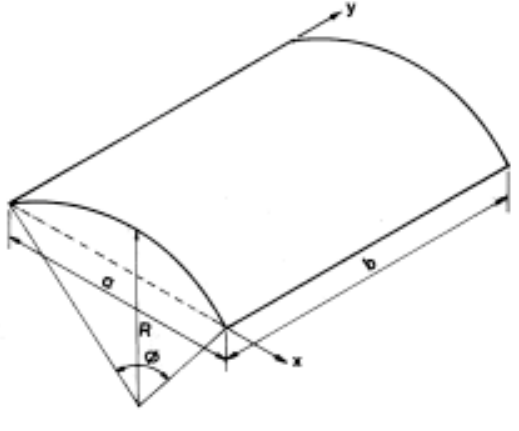
Fig. 3. Geometry and axis system of a cylindrical shell